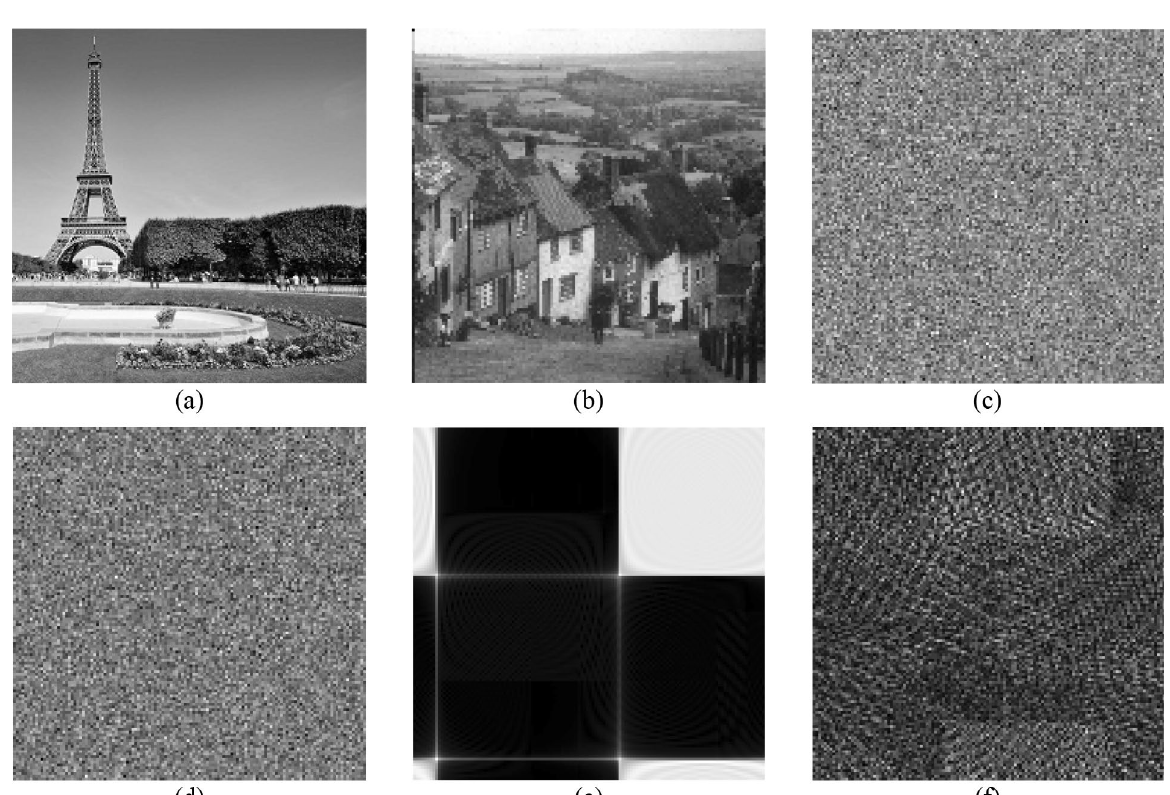
Figure 12. The known plaintext attack and chosen plaintext attack results: ( a ) the first test image, ( b ) the second test image, ( c ) the encrypted pattern of ( a ), ( d ) the encrypted pattern of ( b ), ( e ) the result of known plaintext attack and ( f ) the result of chosen plaintext